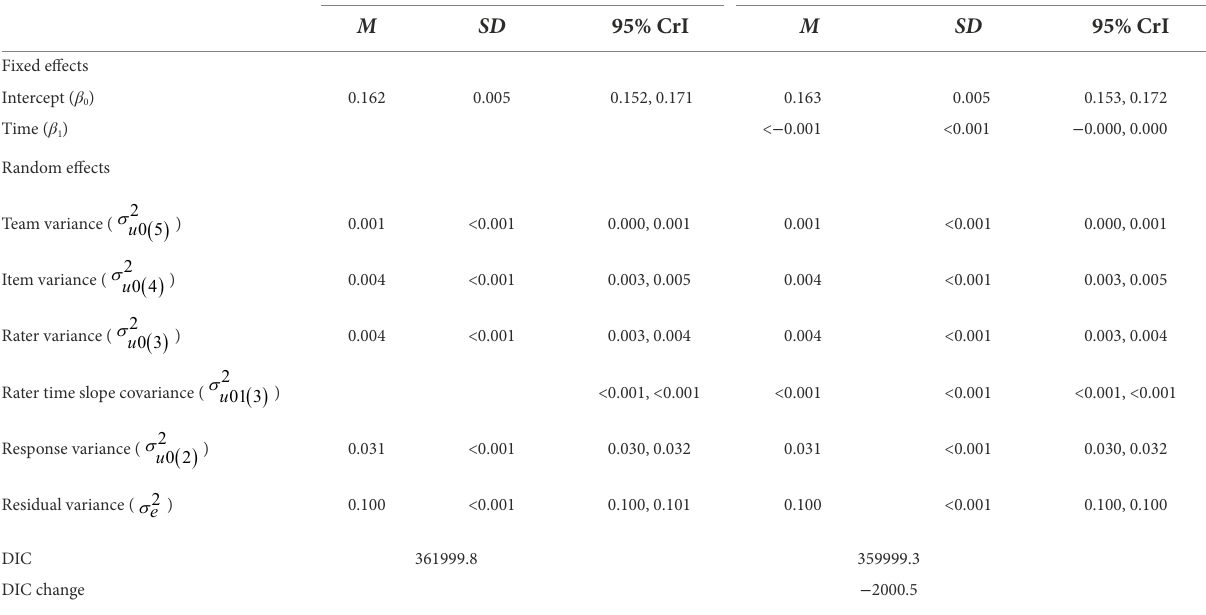
TABLE 2 Parameter estimates for models 1 and